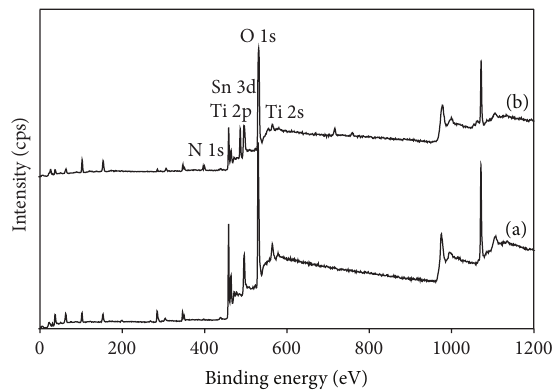
Figure 6: XPS spectra of (a) TiO 2 and (b) 20N/3SnO 2 /TiO 2 thin films, calcined at 600 ∘ C.